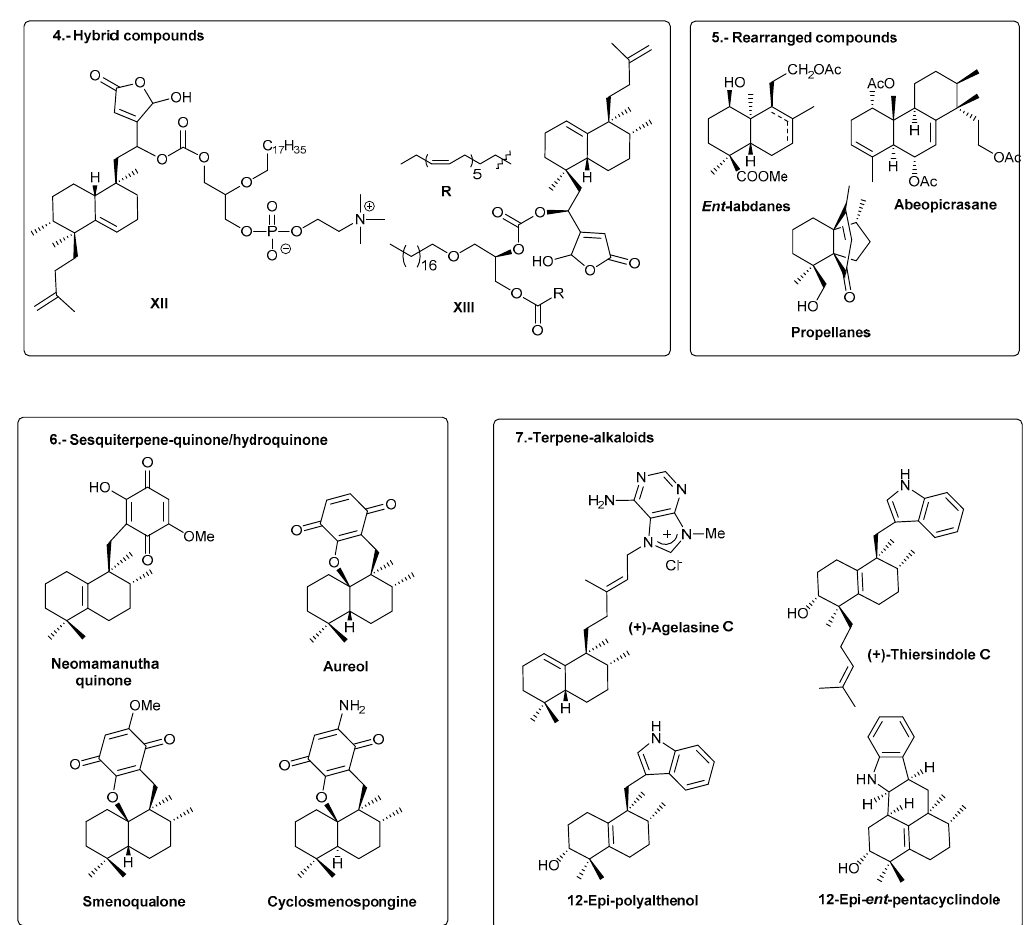
Figure 6. Hybrid and rearranged compounds, sesquiterpene-quinones/hydroquinone, and terpene alkaloids obtained from 2 .